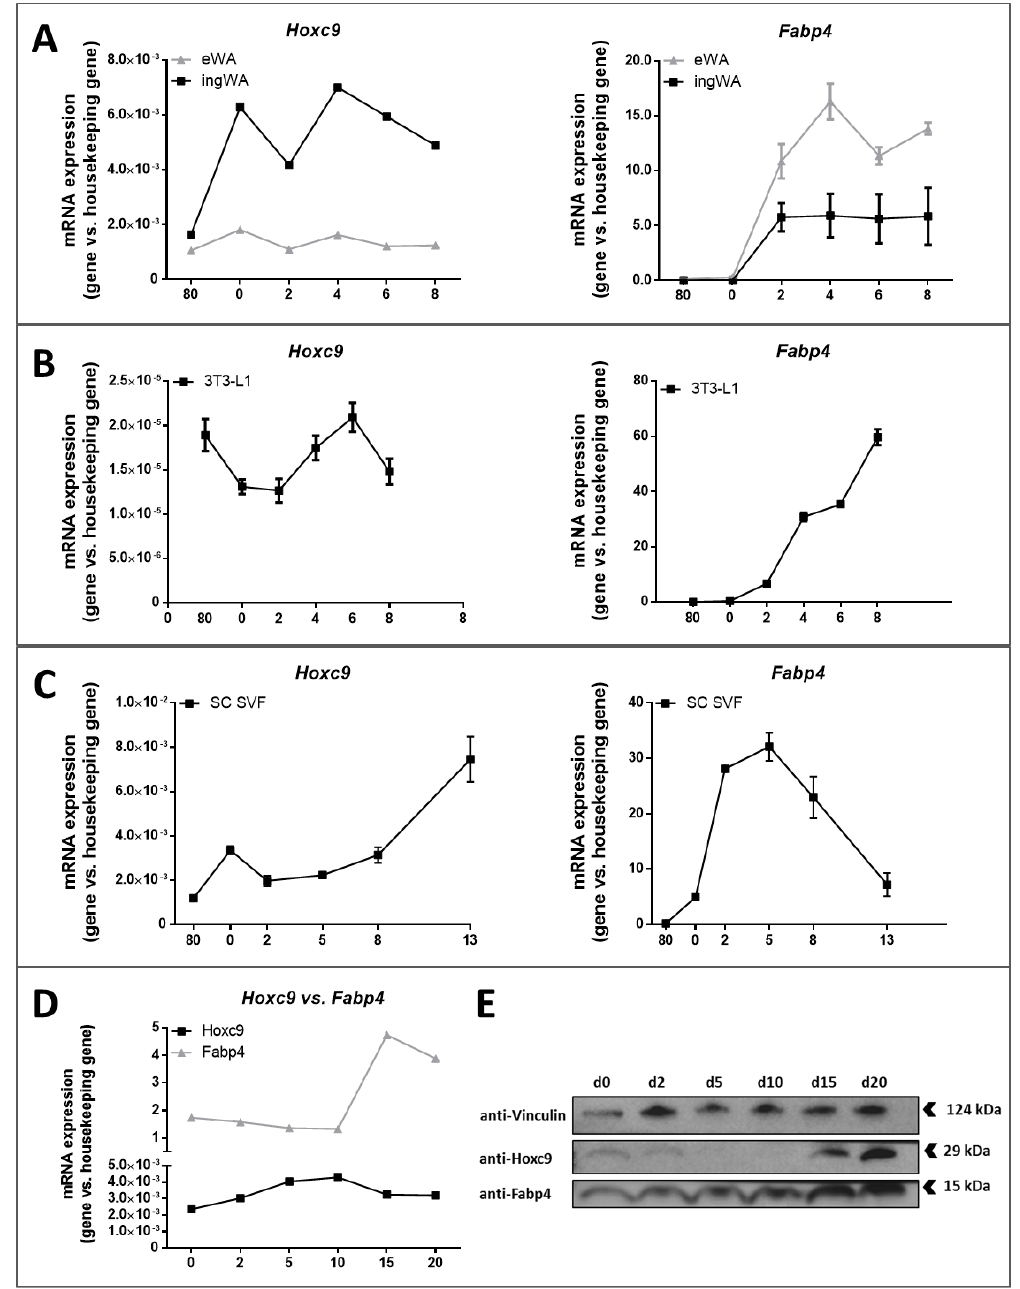
Figure 6. Gene and protein expression patterns of Hoxc9 and Fabp4 in different in vitro and in vivo models. All gene expression experiments were performed using LightCycler 480 and SybrGreen I assay. Mapped time points were at 80% pre-confluence (80), 100% confluence, and initiation of differentiation (0) and days post-confluence (2 – 8 or 13, respectively). Expression values were relative to housekeeping gene expression levels. ( A ) Immortalized inguinal and epididymal adipocytes. Gene expression levels were related to 36B4 and Actb expression patterns. ( B ) 3T3-L1 cell line. Gene expression levels were related to 36B4 and Actb expression patterns. ( C ) SVF cells isolated from ingWAT of C57BL/6NTac mice. Gene expression levels were related to 36B4 , Ppia , and Himbs expression patterns. n = 2. ( D ) Gene expression levels of Hoxc9 and Fabp4 in ingWAT. Expression levels were related to 36b4 and Actb expression patterns. n = 2 animals per time point. Data represented as the mean ± SEM. ( E ) Representative Western blot of newborn male mice to determine protein levels during in vivo adipogenesis. Arrows represent the expected product